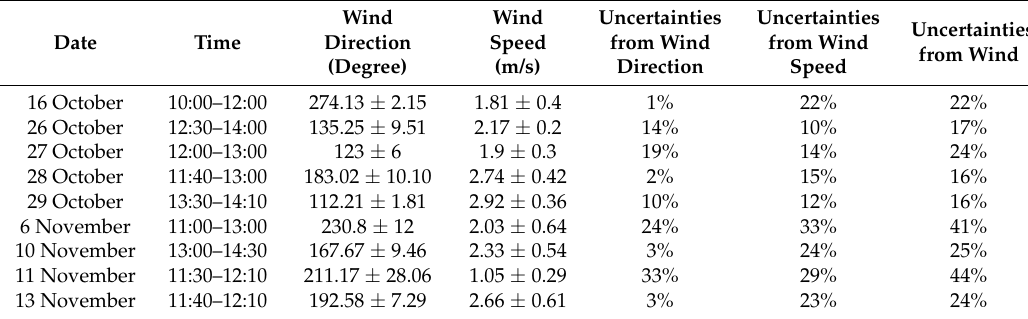
Table 2. Wind field uncertainty of emission